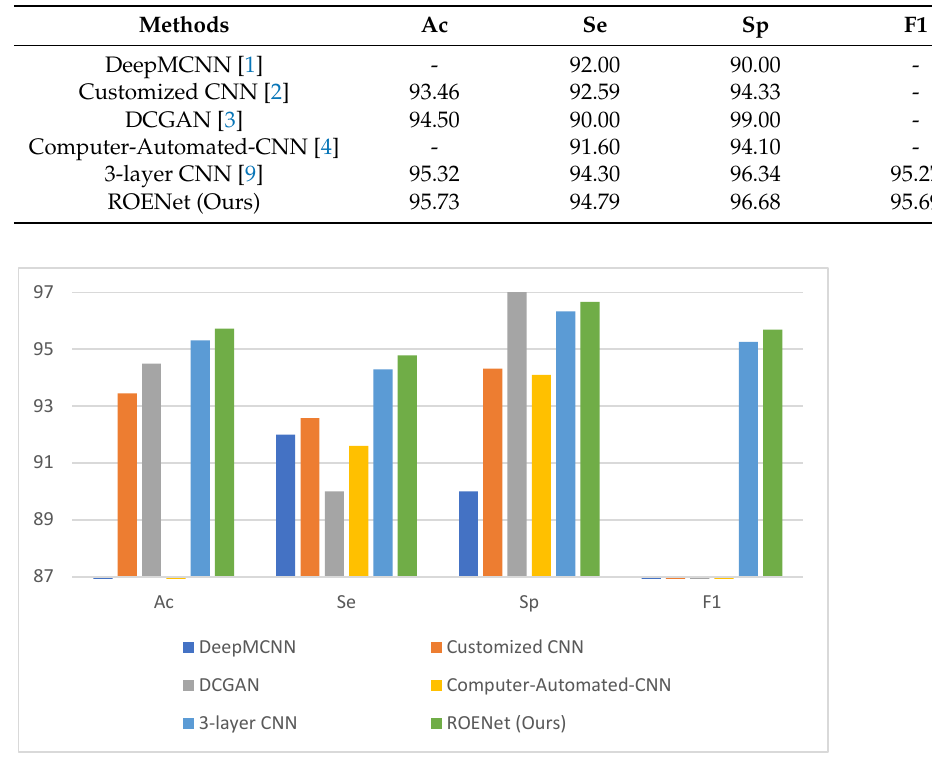
Figure 9. The comparison with other state-of-the-art methods.